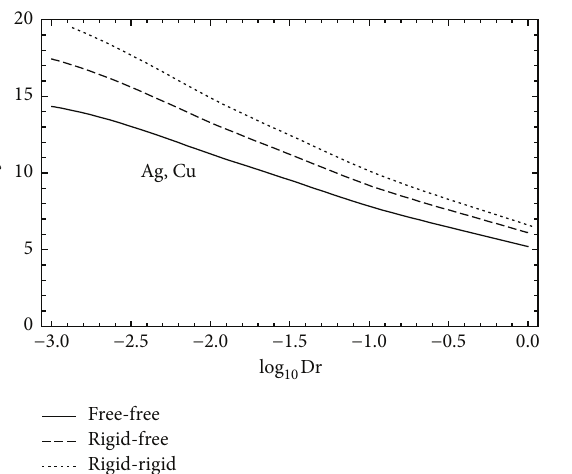
Figure 6: Plot of Ra 𝑐 with porosity for fixed Dr = 0.01 and 𝑄 = 250 .